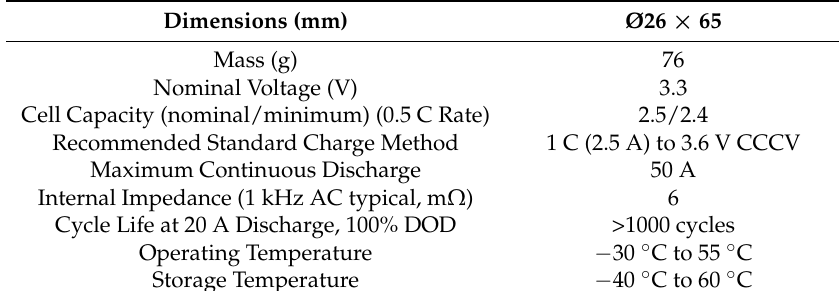
Table 1. Primary specifications of cell (obtained from the a123batteries.com datasheet). CCCV: